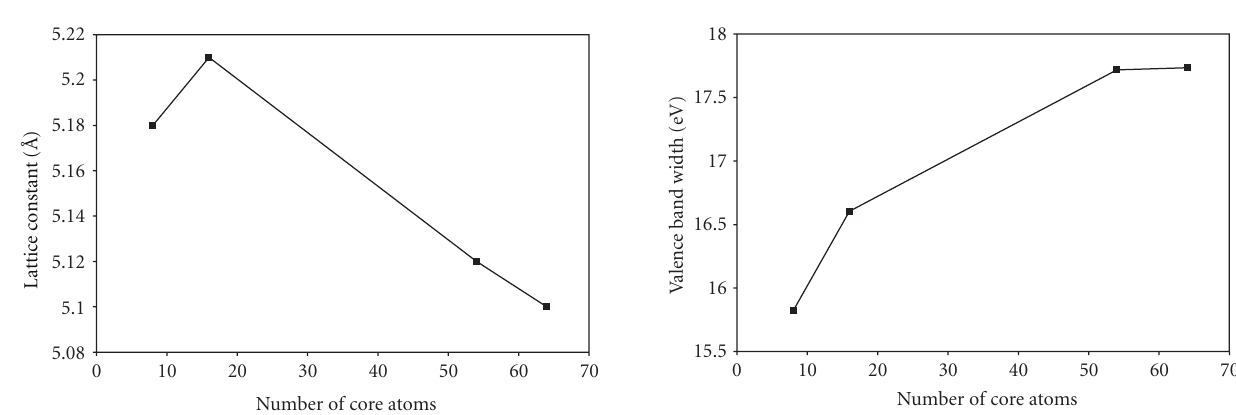
Figure 6: Lattice constant variation as a function of number of core atoms in LUC-DFT method for GaAs nanocrystals.